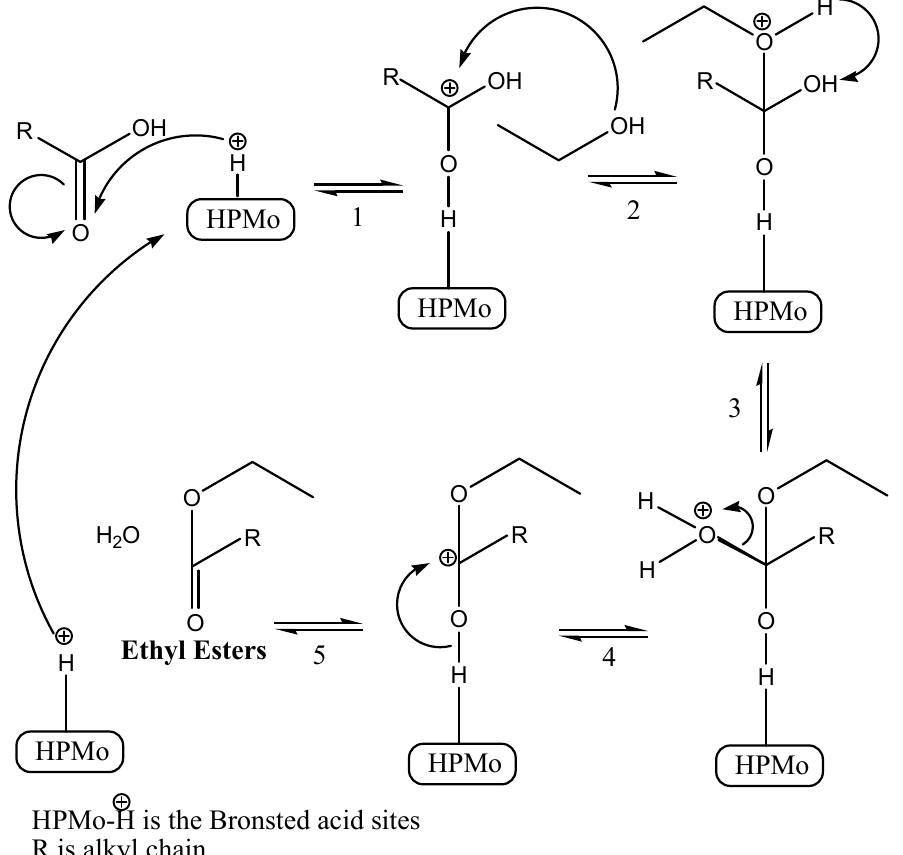
Figure 12. The reaction mechanism for esterification catalyzed by BLMW or BCMW.